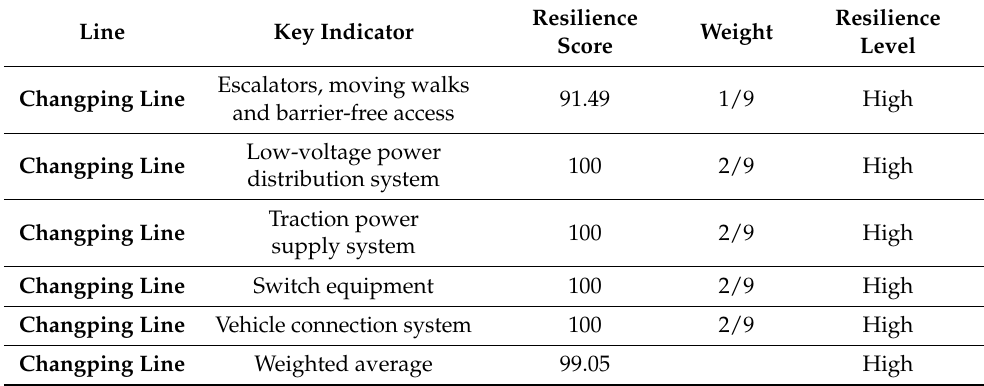
Line Key Indicator